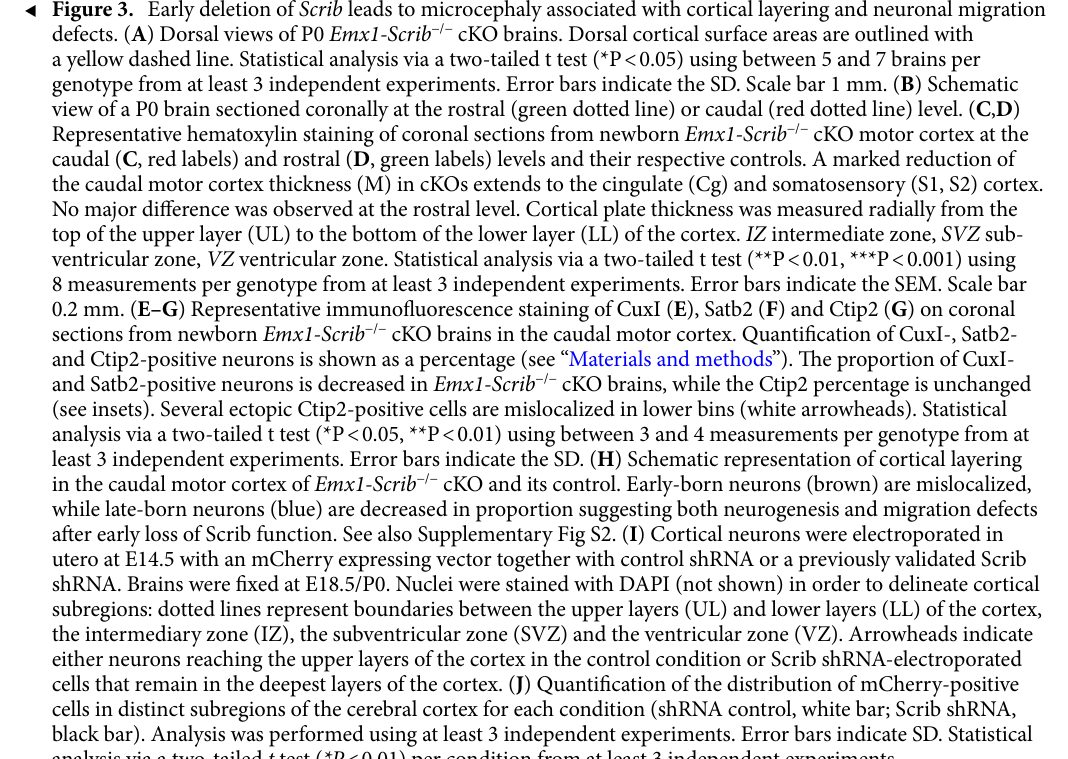
Figure 3. Early deletion of Scrib leads to microcephaly associated with cortical layering and neuronal migration defects. ( A ) Dorsal views of P0 Emx1-Scrib −/− cKO brains. Dorsal cortical surface areas are outlined with a yellow dashed line. Statistical analysis via a two-tailed t test (*P < 0.05) using between 5 and 7 brains per genotype from at least 3 independent experiments. Error bars indicate the SD. Scale bar 1 mm. ( B ) Schematic view of a P0 brain sectioned coronally at the rostral (green dotted line) or caudal (red dotted line) level. ( C , D ) Representative hematoxylin staining of coronal sections from newborn Emx1-Scrib −/− cKO motor cortex at the caudal ( C , red labels) and rostral ( D , green labels) levels and their respective controls. A marked reduction of the caudal motor cortex thickness (M) in cKOs extends to the cingulate (Cg) and somatosensory (S1, S2) cortex. No major difference was observed at the rostral level. Cortical plate thickness was measured radially from the top of the upper layer (UL) to the bottom of the lower layer (LL) of the cortex. IZ intermediate zone, SVZ sub- ventricular zone, VZ ventricular zone. Statistical analysis via a two-tailed t test (**P < 0.01, ***P < 0.001) using 8 measurements per genotype from at least 3 independent experiments. Error bars indicate the SEM. Scale bar 0.2 mm. ( E–G ) Representative immunofluorescence staining of CuxI ( E ), Satb2 ( F ) and Ctip2 ( G ) on coronal sections from newborn Emx1-Scrib −/− cKO brains in the caudal motor cortex. Quantification of CuxI-, Satb2- and Ctip2-positive neurons is shown as a percentage (see “Materials and methods”). The proportion of CuxI- and Satb2-positive neurons is decreased in Emx1-Scrib −/− cKO brains, while the Ctip2 percentage is unchanged (see insets). Several ectopic Ctip2-positive cells are mislocalized in lower bins (white arrowheads). Statistical analysis via a two-tailed t test (*P < 0.05, **P < 0.01) using between 3 and 4 measurements per genotype from at least 3 independent experiments. Error bars indicate the SD. ( H ) Schematic representation of cortical layering in the caudal motor cortex of Emx1-Scrib −/− cKO and its control. Early-born neurons (brown) are mislocalized, while late-born neurons (blue) are decreased in proportion suggesting both neurogenesis and migration defects after early loss of Scrib function. See also Supplementary Fig S2. ( I ) Cortical neurons were electroporated in utero at E14.5 with an mCherry expressing vector together with control shRNA or a previously validated Scrib shRNA. Brains were fixed at E18.5/P0. Nuclei were stained with DAPI (not shown) in order to delineate cortical subregions: dotted lines represent boundaries between the upper layers (UL) and lower layers (LL) of the cortex, the intermediary zone (IZ), the subventricular zone (SVZ) and the ventricular zone (VZ). Arrowheads indicate either neurons reaching the upper layers of the cortex in the control condition or Scrib shRNA-electroporated cells that remain in the deepest layers of the cortex. ( J ) Quantification of the distribution of mCherry-positive cells in distinct subregions of the cerebral cortex for each condition (shRNA control, white bar; Scrib shRNA, black bar). Analysis was performed using at least 3 independent experiments. Error bars indicate SD. Statistical analysis via a two-tailed t test ( *P < 0.01) per condition from at least 3 independent